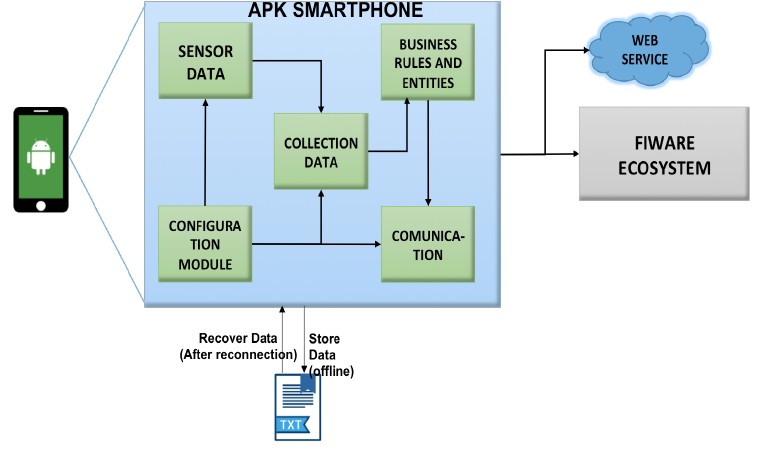
Figure 4.Architecture of our module